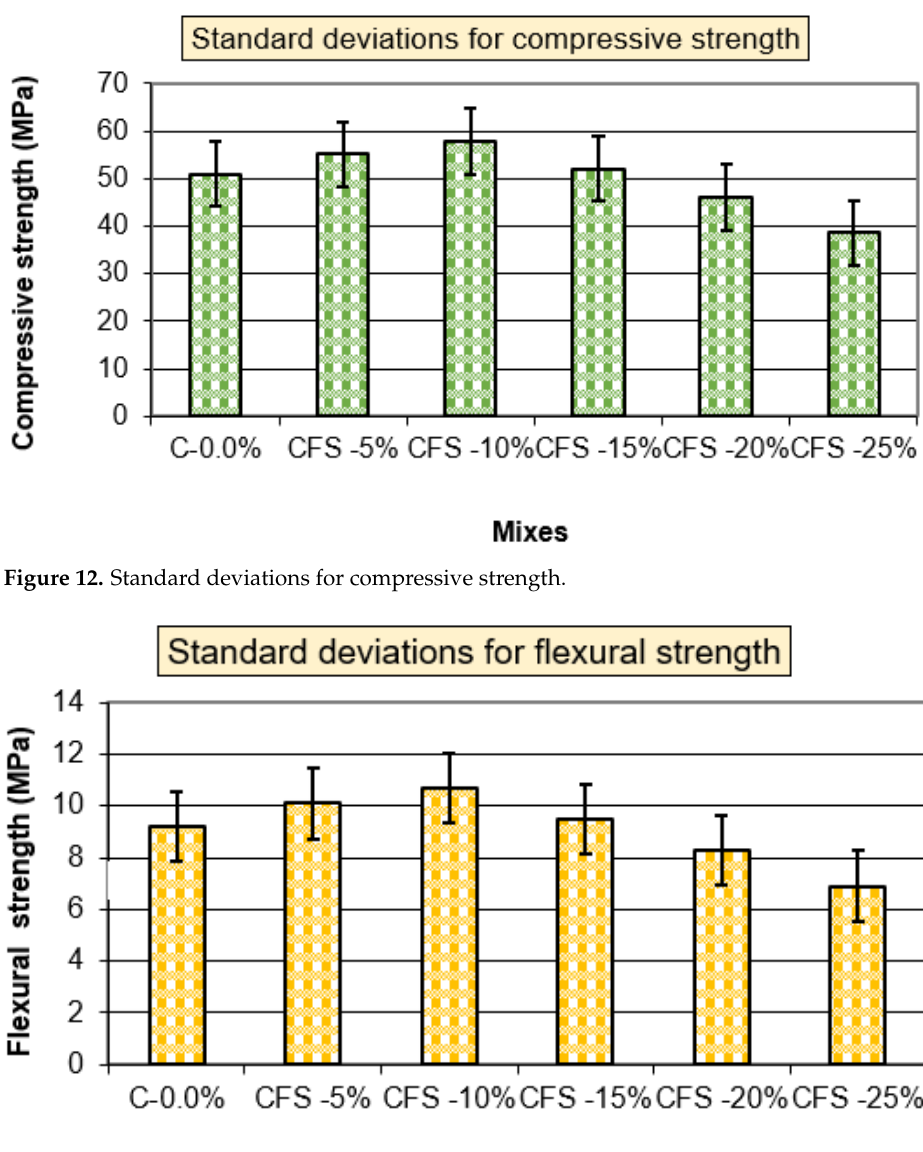
Figure 13. Standard deviations for flexural strength.